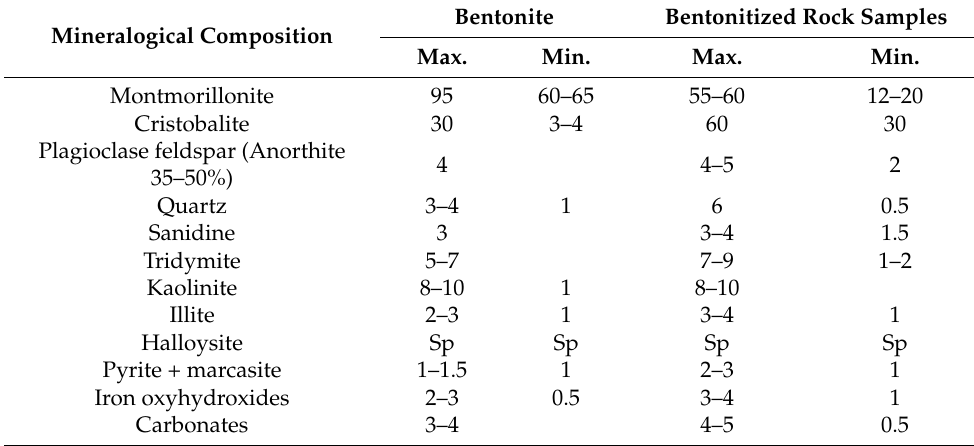
Table 3. Synthetic table of the minerals and their mass fraction limits determined using XRD in the studied bentonites and bentonitized rocks. (Sp = sporadically). Bentonite Bentonitized Rock Samples Mineralogical Composition